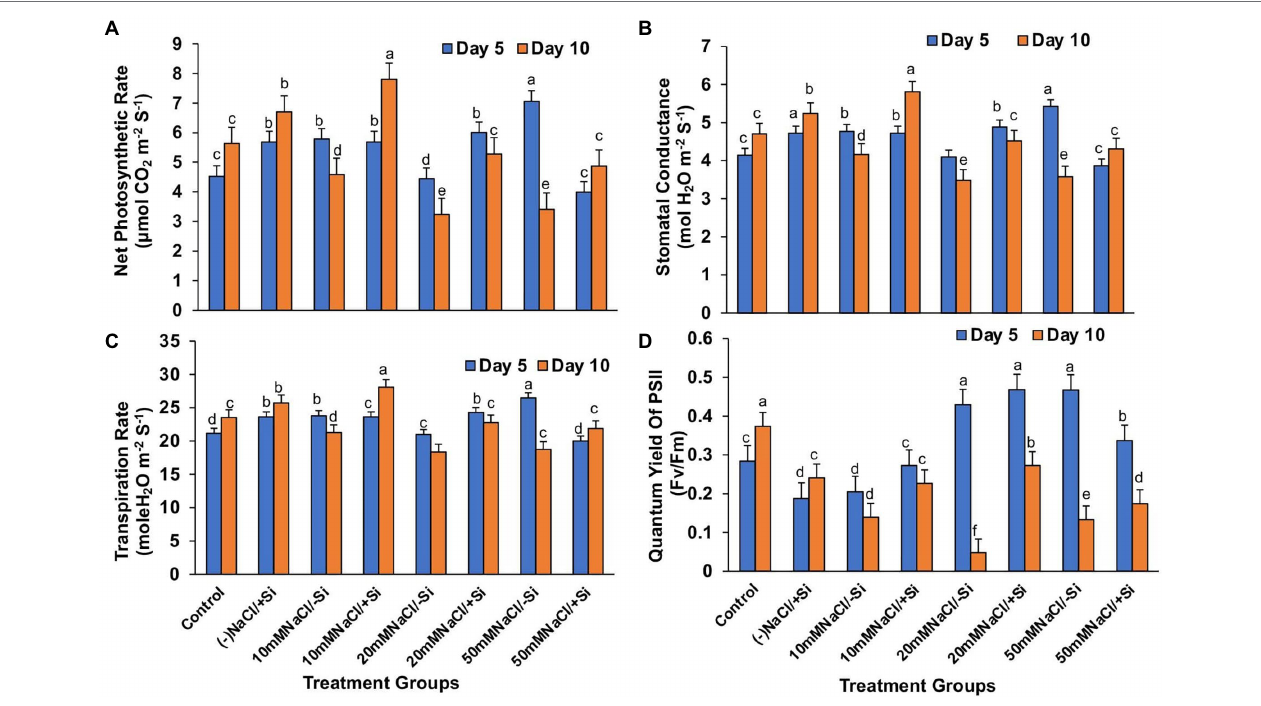
FIGURE 5 | Changes in (A) net photosynthesis, (B) stomatal conductance, (C) transpiration rate, and (D) PSII quantum yield of mung bean ( Vigna radiata ) under 5 mM (Si 2 ) Si supply and salinity stress after eight treatments: (i) control (T1), (ii) − NaCl+Si (5 mM) (T2), (iii) 10 mM NaCl/ − Si (T3), (iv) 10 mM NaCl/+Si (5 mM) (T4), (v) 20 mM NaCl/ − Si (T5), (vi) 20 mM NaCl/+Si (5 mM) (T6), (vii) 50 mM NaCl/ − Si (T7), and (viii) 50 mM NaCl/+Si (5 mM) (5 mM) (T8) for a period of 5 and 10 days. Vertical bars indicate Mean ± SE of the means for n = 4. Means denoted by the different letters are significantly different at p ≤ 0.05 according to the Tukey’s studentized range